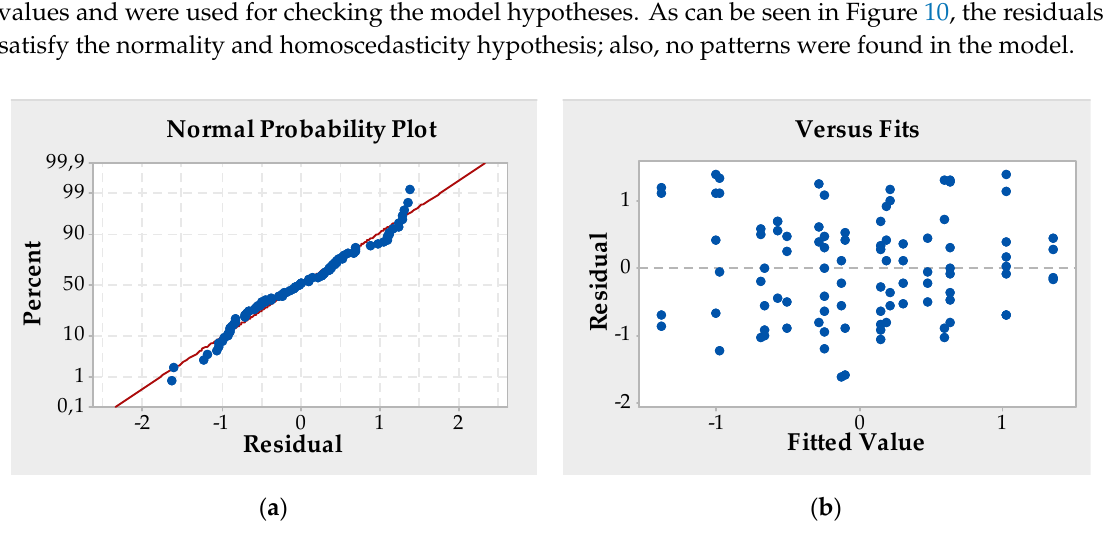
Table 7. Predicted Ra, measured Ra, and absolute error for levels and effects combinations.